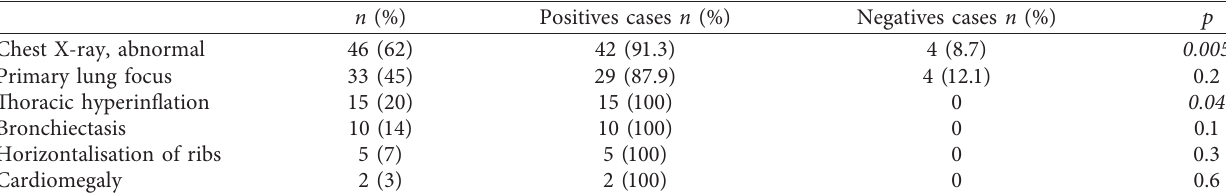
Abdominal signs Hepatomegaly MAP: mean arterial pressure, CRT: capillary refill Table 3: The chest X-ray results (December 1, 2016, to May 31, 2018; N � 74).